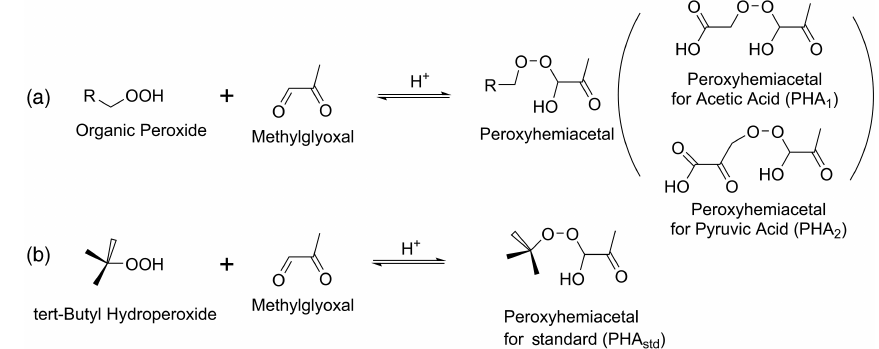
Figure 2. Acid-catalyzed peroxyhemiacetal formation from a precursor, methylglyoxal, with organic peroxide products of aqueous photoox- idation (a) and from methylglyoxal with tert -butyl hydroperoxide in standard solutions (b) .